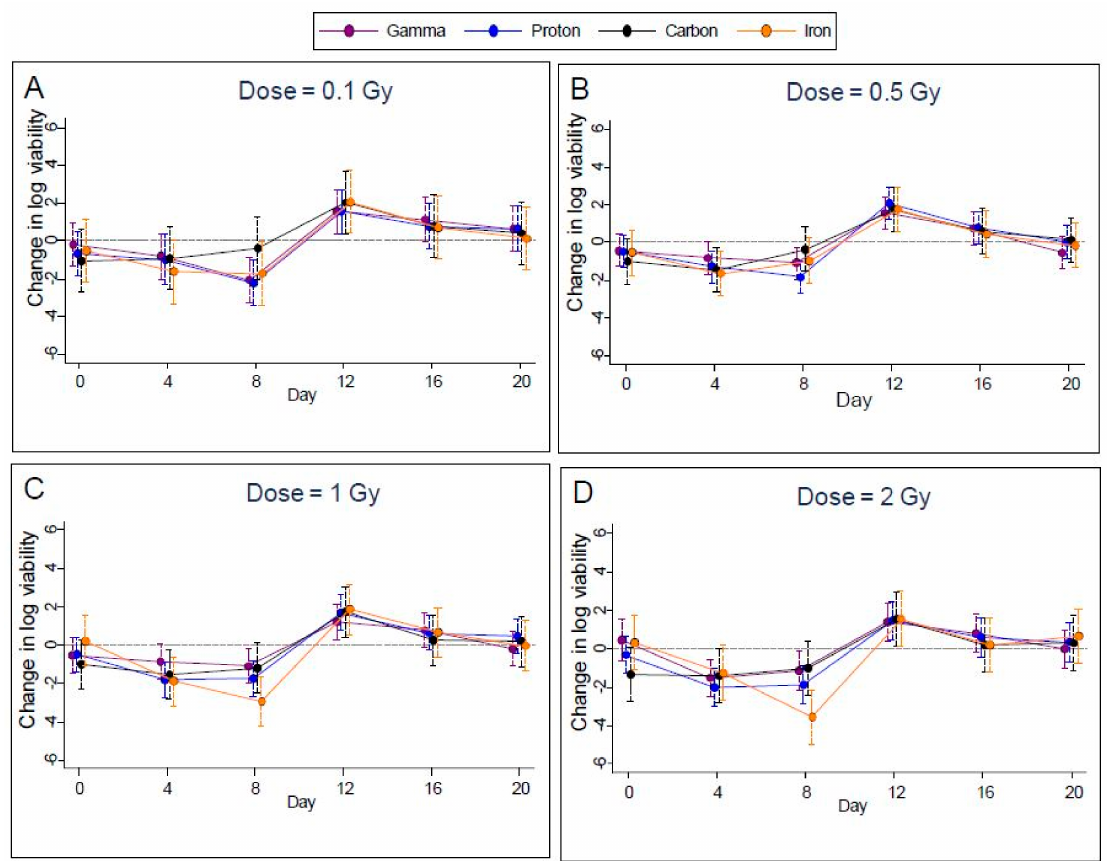
Figure 4. Change in cell viability compared to controls following gamma, proton, carbon, and iron radiation treatments at different dosages ( A ); 0.1, ( B ); 0.5, ( C ), 1.0 and ( D ), 2.0 Gy with 95% confidence limits